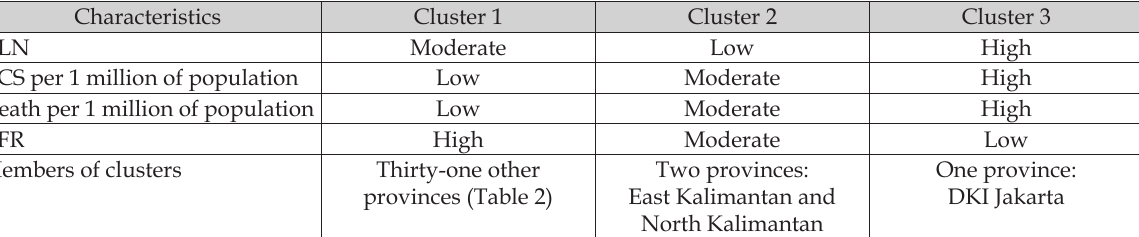
Table 1. Attributes of clusters and